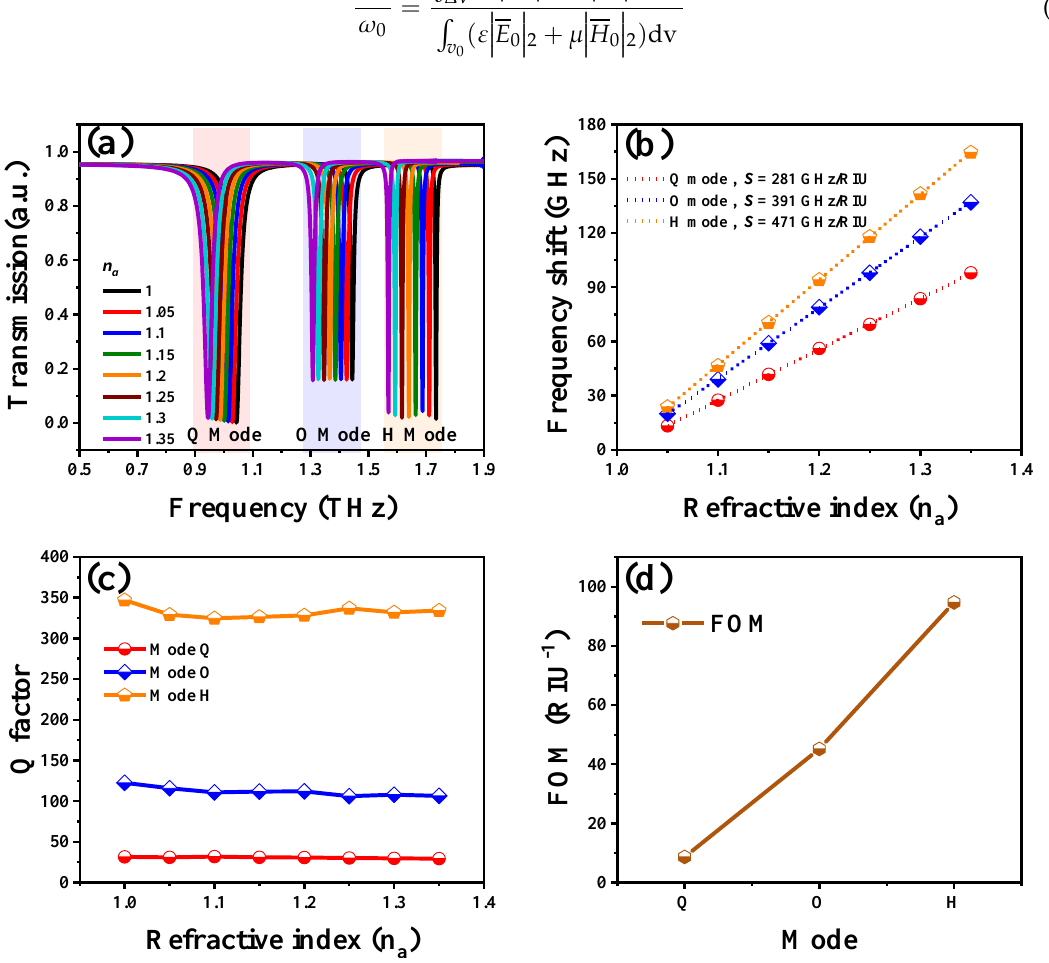
Figure 5. ( a ) Transmission spectra of SSM covered with different analyte thin-films. ( b ) Frequency shifts and ( c ) Q-factors plotted against the n a values. ( d ) The average FOM values of Q, O and H modes. The dielectric hemispheres were introduced to imitate the detection of cells, such as the monitoring of cell apoptosis, as shown in Figure 1d. The refraction index of dielectric hemispheres ( n c ) was investigated to study the electromagnetic behaviors of SSM for biosensing applications.